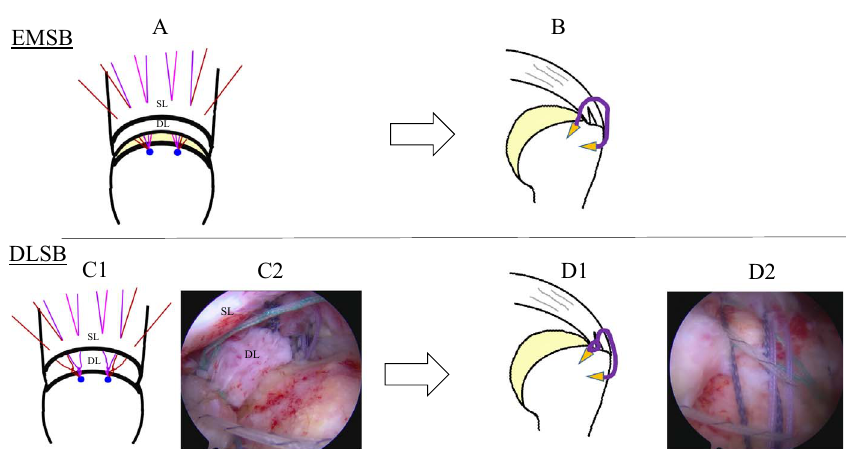
Figure 1. EMSB and DLSB procedures. For EMSB, a suture is passed through the super fi cial and deep layers (A) and bridged with lateral anchors (B). For DLSB, the super fi cial layer is fi rst repaired with medial anchors (C); then, the remaining sutures are passed through the deep layer and bridged with lateral anchors (D). Abbreviations: EMSB: en masse suture bridge, DLSB: double layer suture bridge, SL: super fi cial layer, DL: deep layer, C2 and D2: arthroscopic images of the right shoulder as viewed from the posterolateral portal.